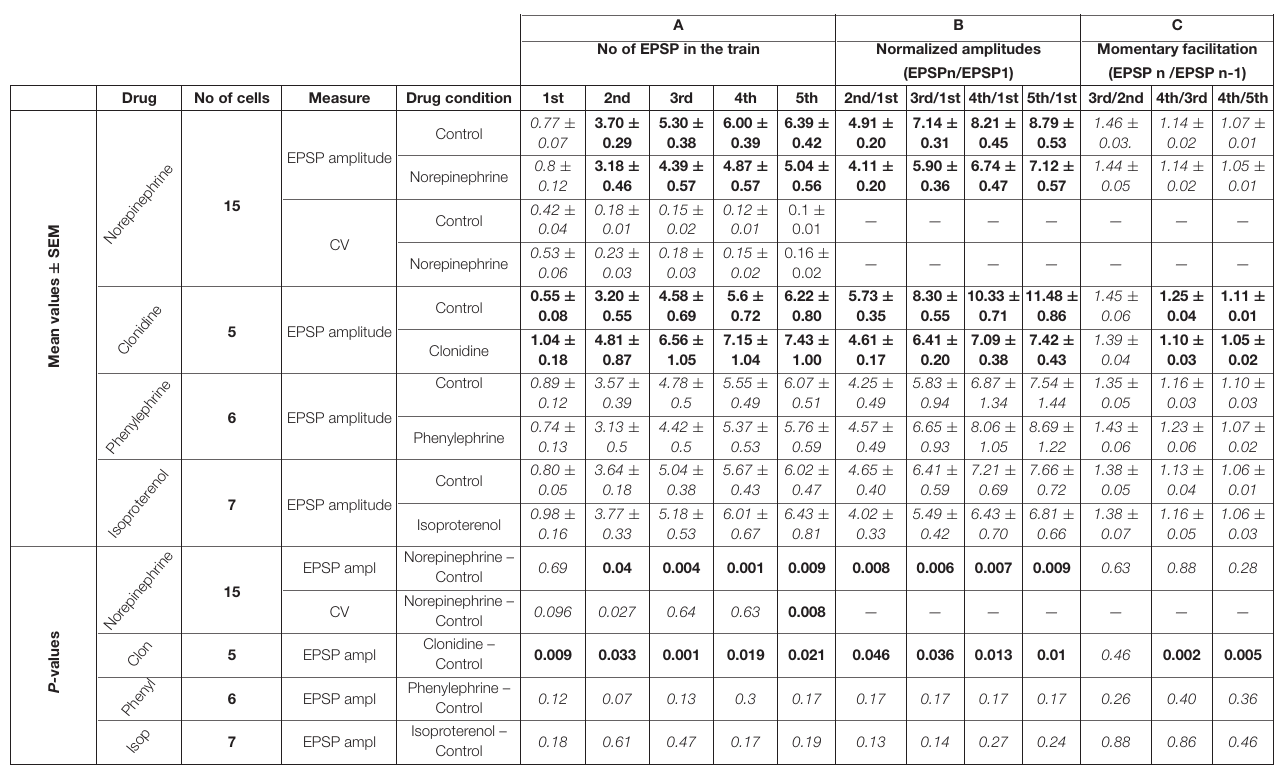
TABLE 2 | Noradrenergic effects.